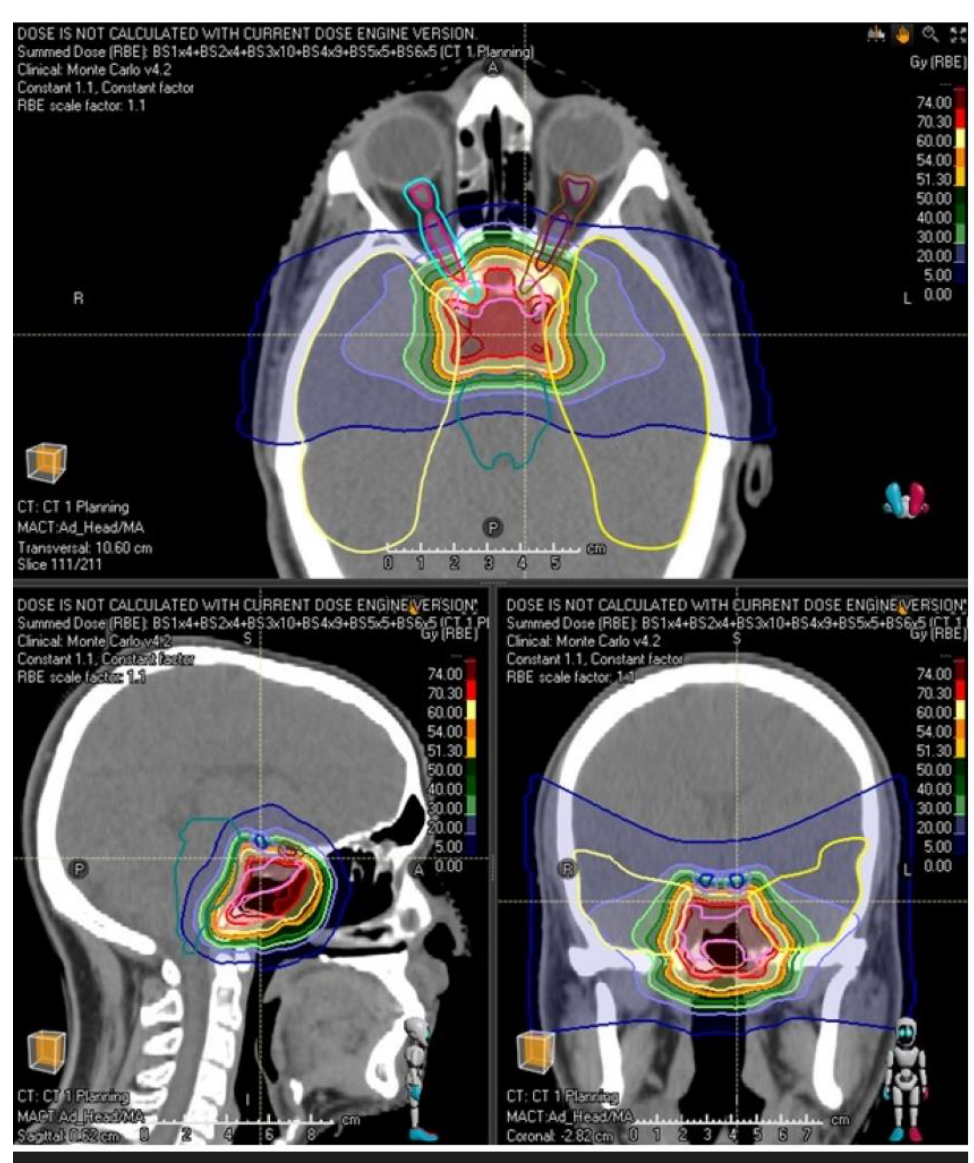
Figure 1. Proton beam therapy plan for skull base chordoma showing steep dose-gradient with sharp dose fall off in proximity of the optic pathways and brainstem.